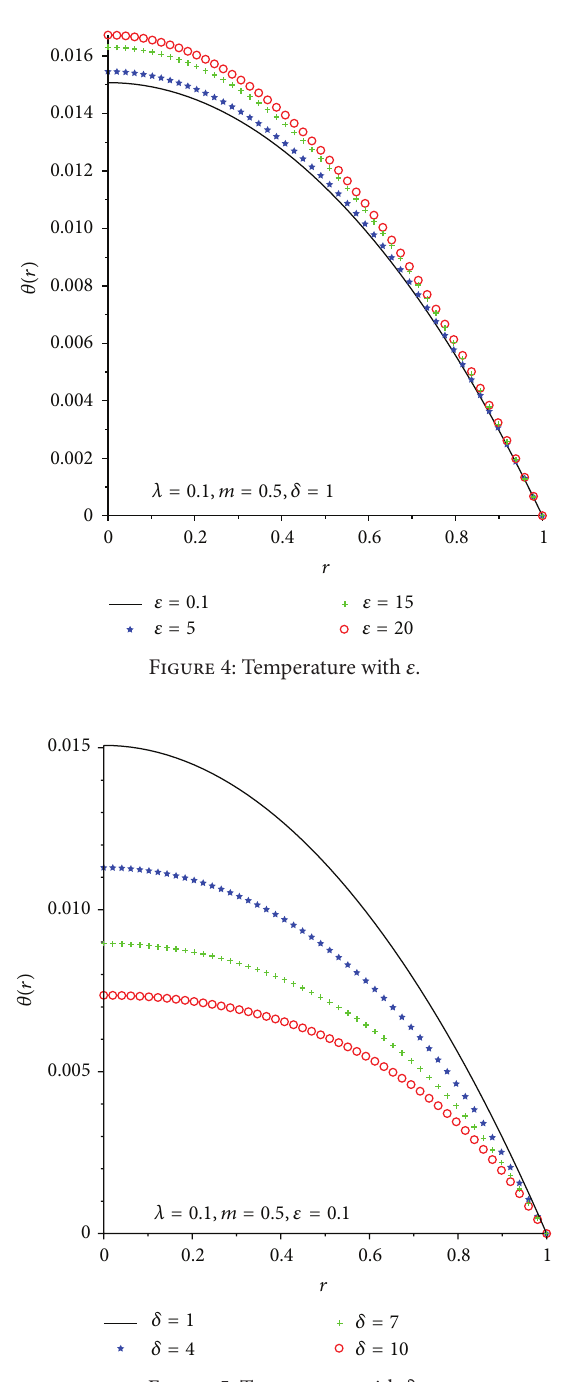
Figure 5: Temperature with 𝛿 .